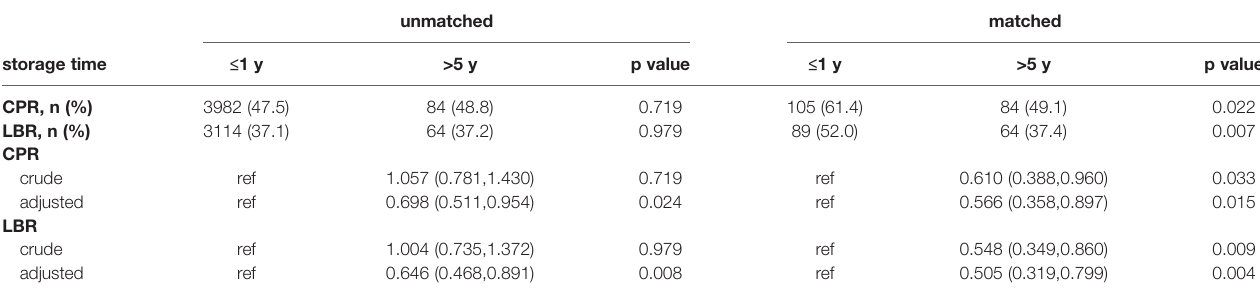
TABLE 6 | The results and odds ratio of CPR and LBR in Group ≤ 1 year and Group >5 years before and after matching. unmatched matched storage